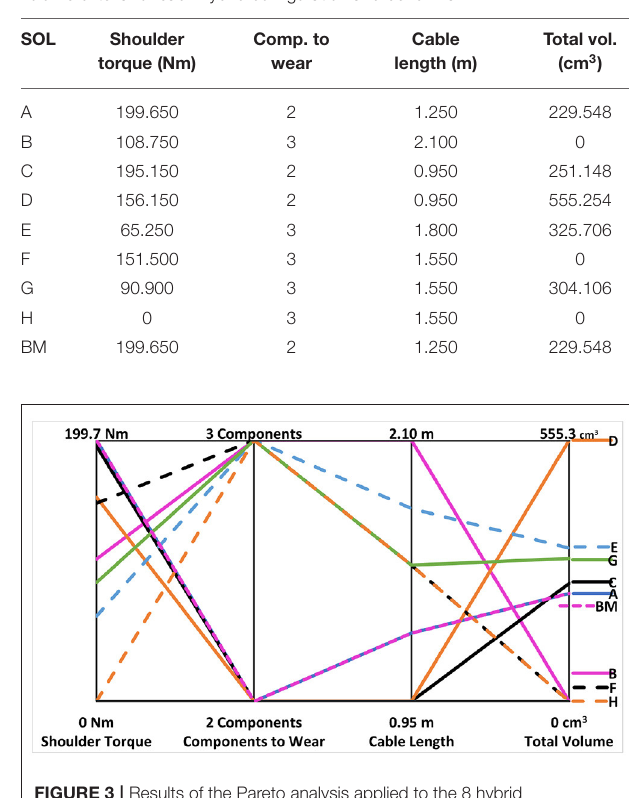
anthropometric measurements from McConville et al. (1980); Dempster (1955). As discussed above, comfort in term of cables is highlighted as an important aspect for body-powered users (Biddiss et al., 2007). In addition to comfort, cabling